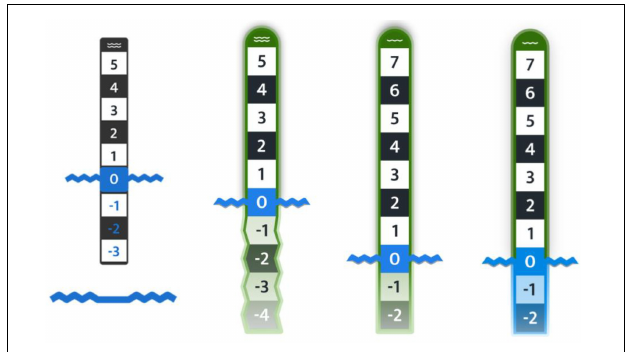
FIGURE 7 | Various staff gauge designs. Design/author: Philipp Hummer, SPOTTERON Citizen Science, www.spotteron.net.